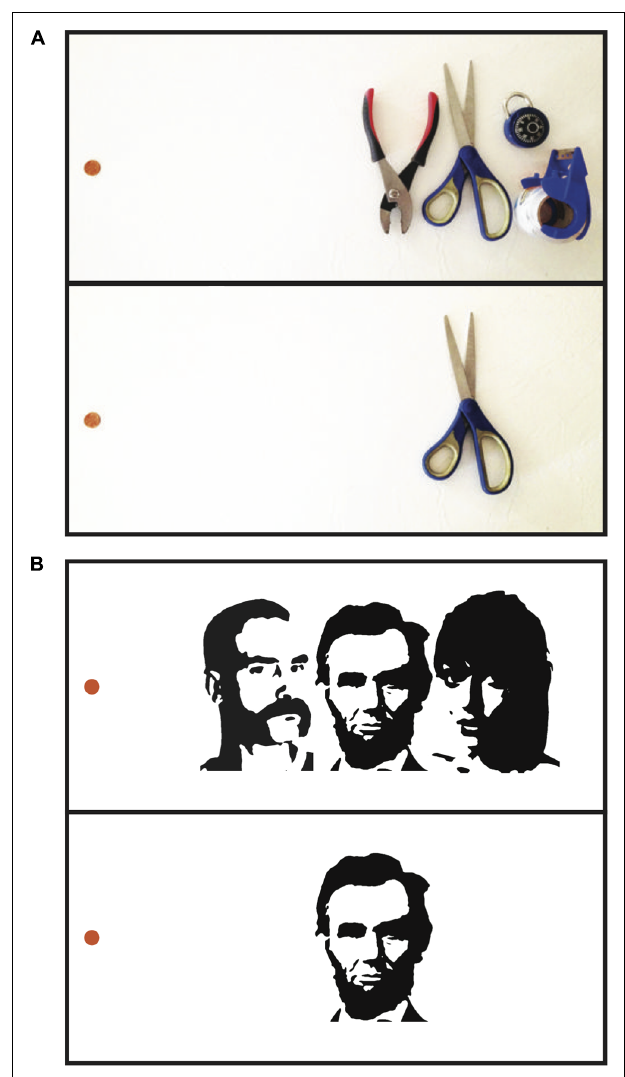
FIGURE 1 |Visual crowding. (A) When fixating the penny on the left in the upper panel, the center object on the right is difficult to identify, although it is clear that something is present in the center. In the lower panel, in the absence of surrounding clutter, identifying the same object at the same eccentricity is much easier. Crowding impairs the ability to recognize (but not the ability to detect) objects amidst visual clutter. (B) Faces crowd each other.While fixating the orange dot in the upper panel, it is relatively difficult to recognize the identity of the central face due to crowding from the flanking faces. In the lower panel, in the absence of flanking faces, the central face is easier to identify. Crowding between faces is not simply due to crowding of low-level features such as edge information – inverting or scrambling the flanking faces, which preserves low-level features but disrupts holistic face information, reduces crowding between faces (Louie etal., 2007; Farzin etal., 2009; Fischer andWhitney,